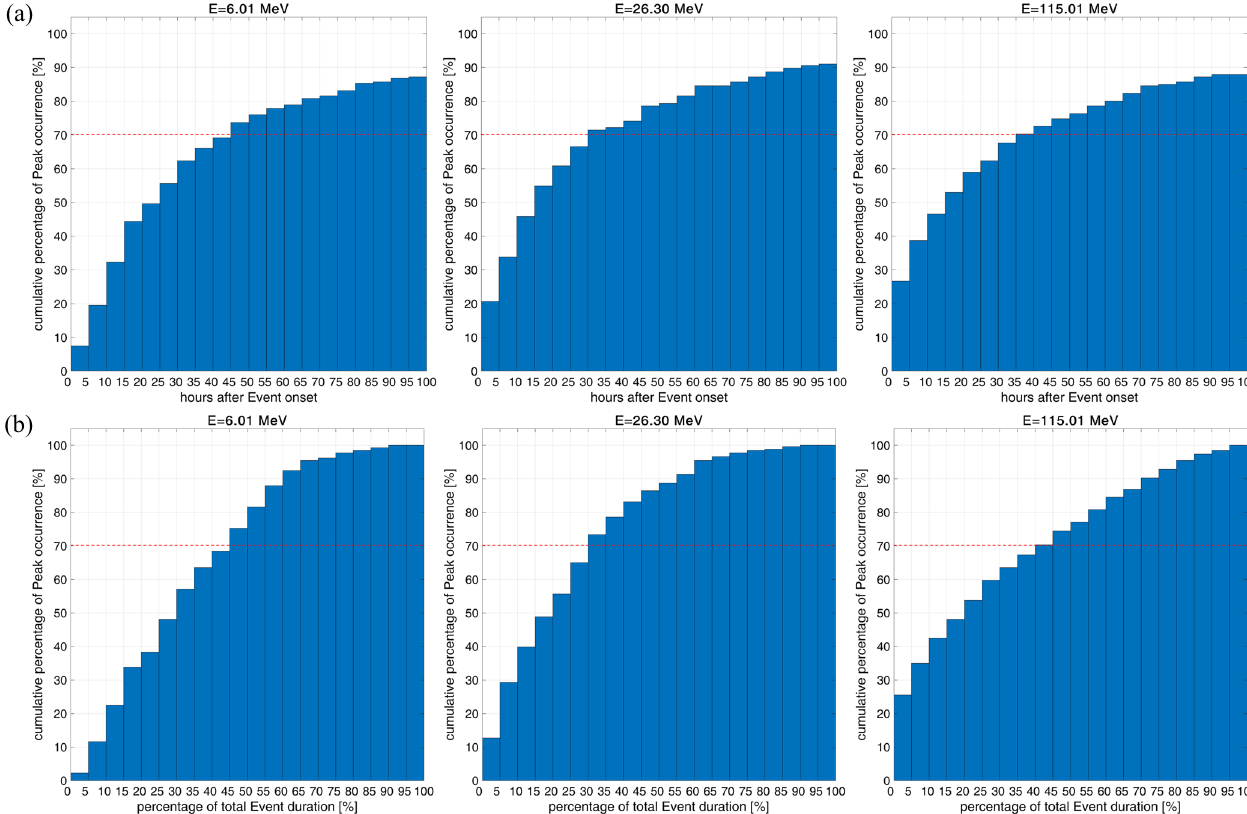
Fig. 15. (a) Cumulative distributions of Peak occurrence in hours after onset at 6 MeV, 26.3 MeV and 115 MeV. (b) Cumulative distributions of Peak occurrence relative to total Event duration at the same energies. Red dashed lines denote the 70%